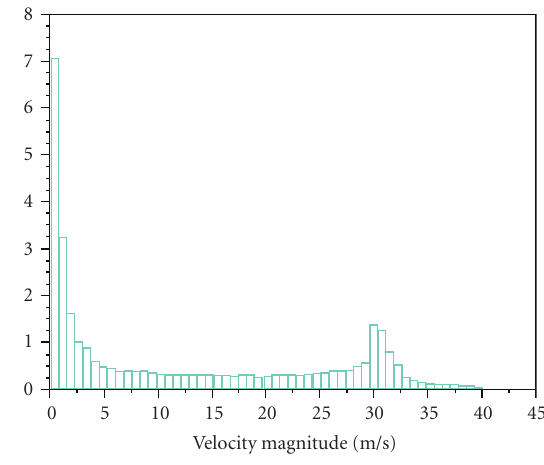
Figure 17: Bar chart showing (normalized) number of points versus velocity for FCC cell “trs1” (LOFA—Average